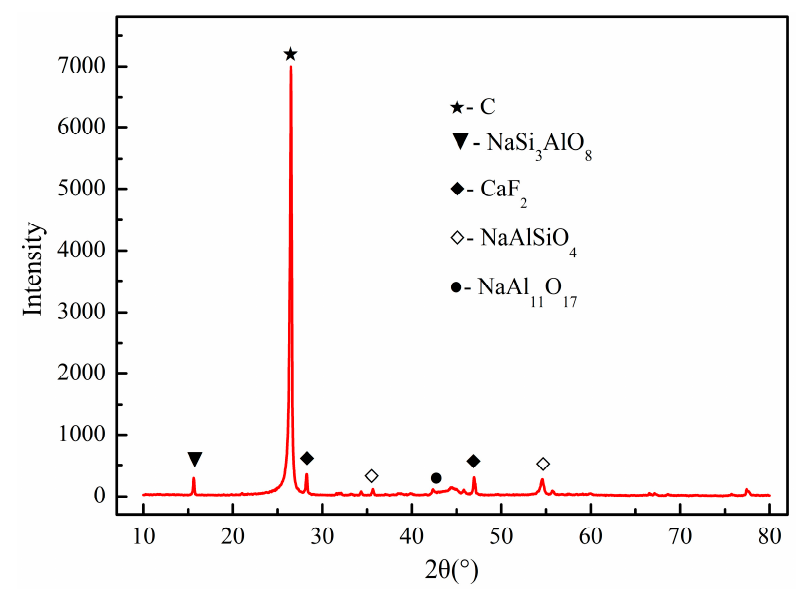
Figure 2. XRD pattern of alkali-fused